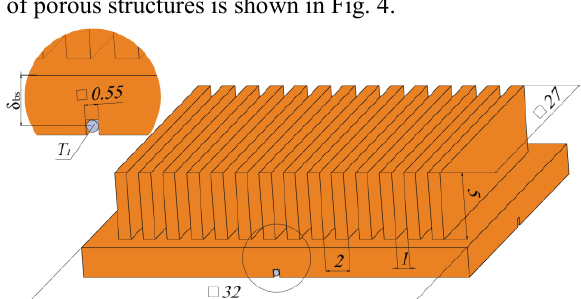
Fig. 3. MC specimen with dimensions in millimetres.